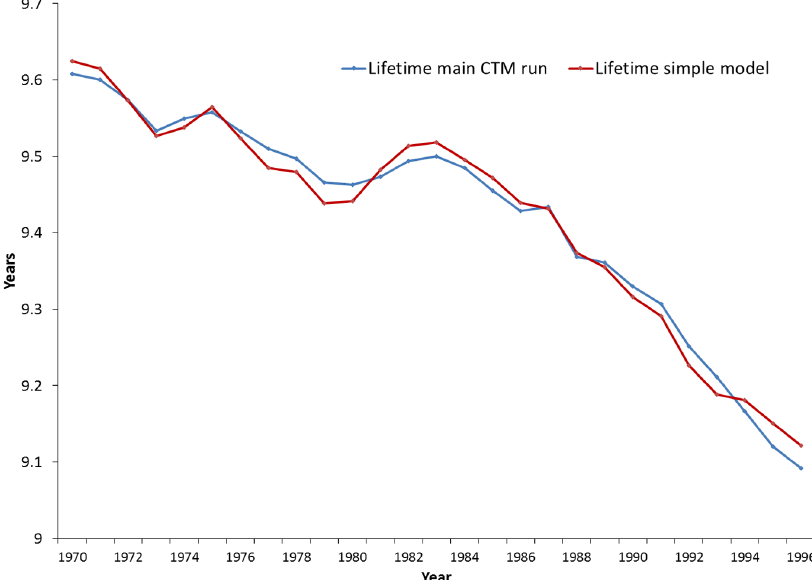
Figure 17. CH 4 lifetime evolution 1970–1996. Comparison of the main model simulation (blue line) with CH 4 lifetime from the simple model (red line) obtained from multiple linear